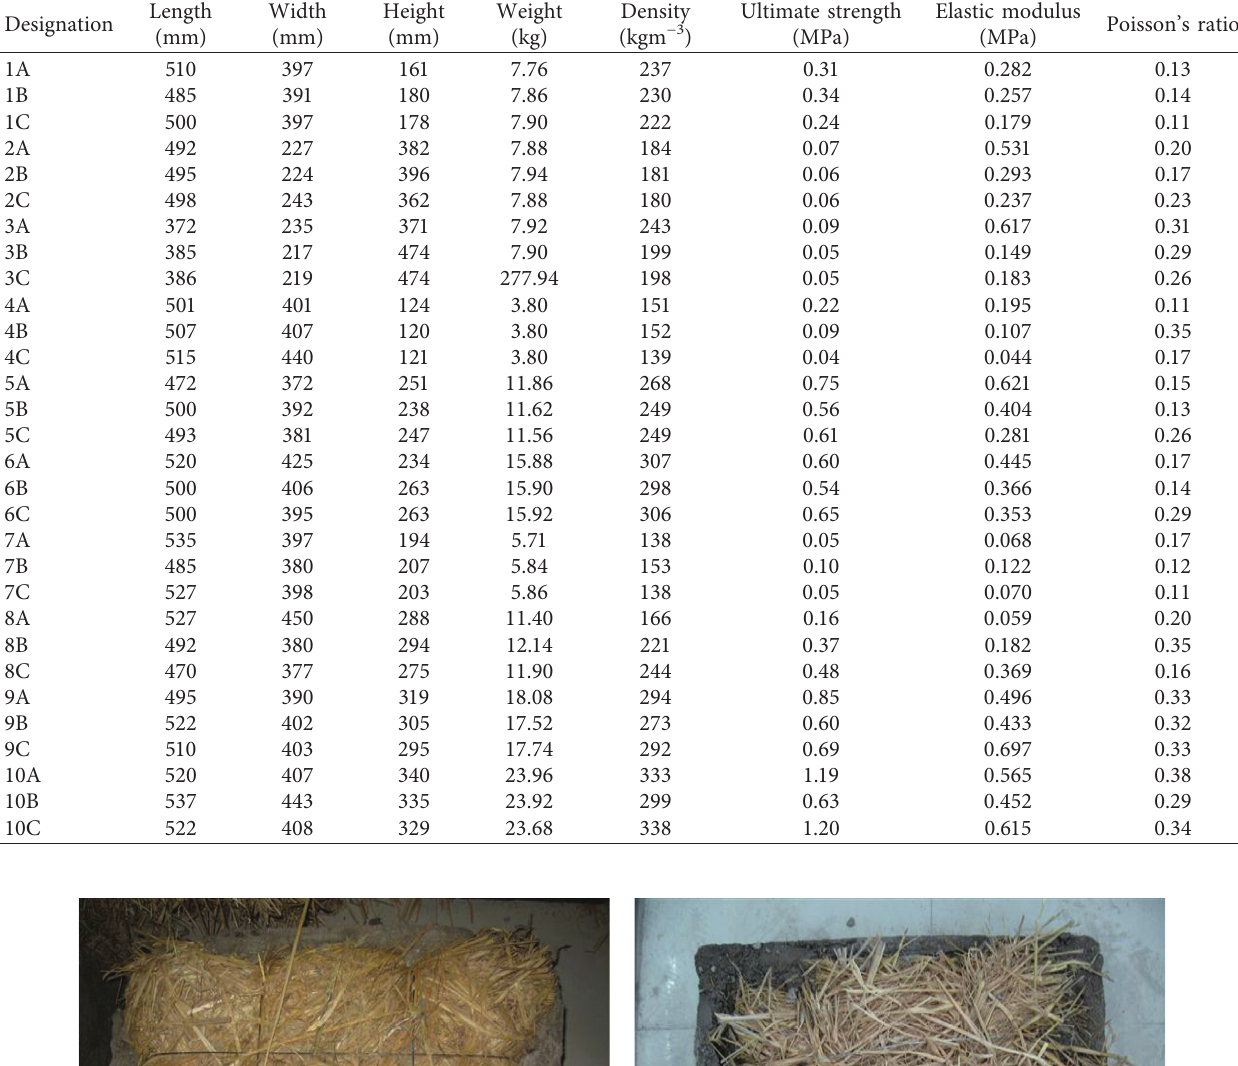
Table 1: The parameters of straw bale